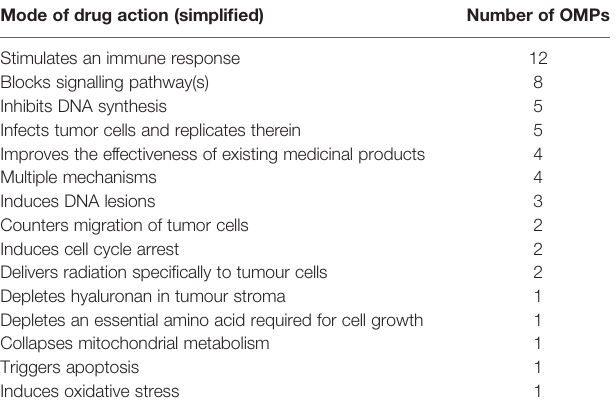
TABLE 1 | Mode of drug action of OMPs for the treatment of pancreatic cancer. Mode of drug action (simpli fi